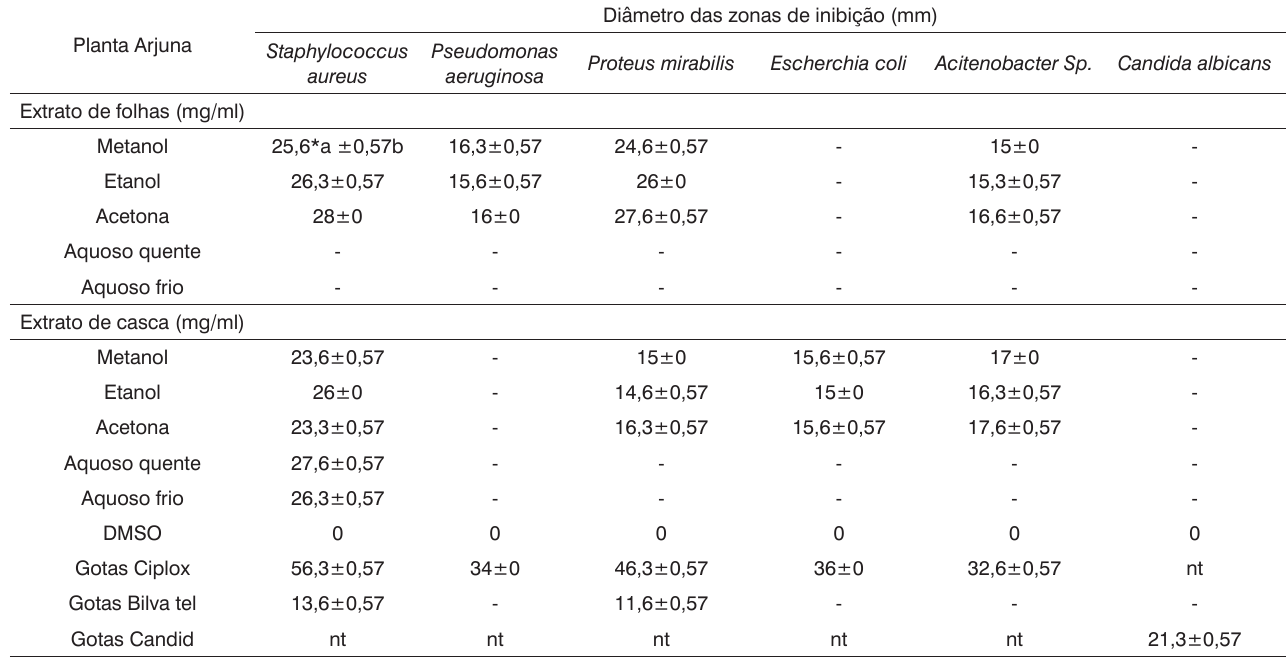
Tabela 1. Atividade antimicrobiana de extratos da casca e folhas da Terminalia arjuna sobre patógenos auditivos, determinado pela técnica da difusão em ágar pelo método do poço. Planta Arjuna